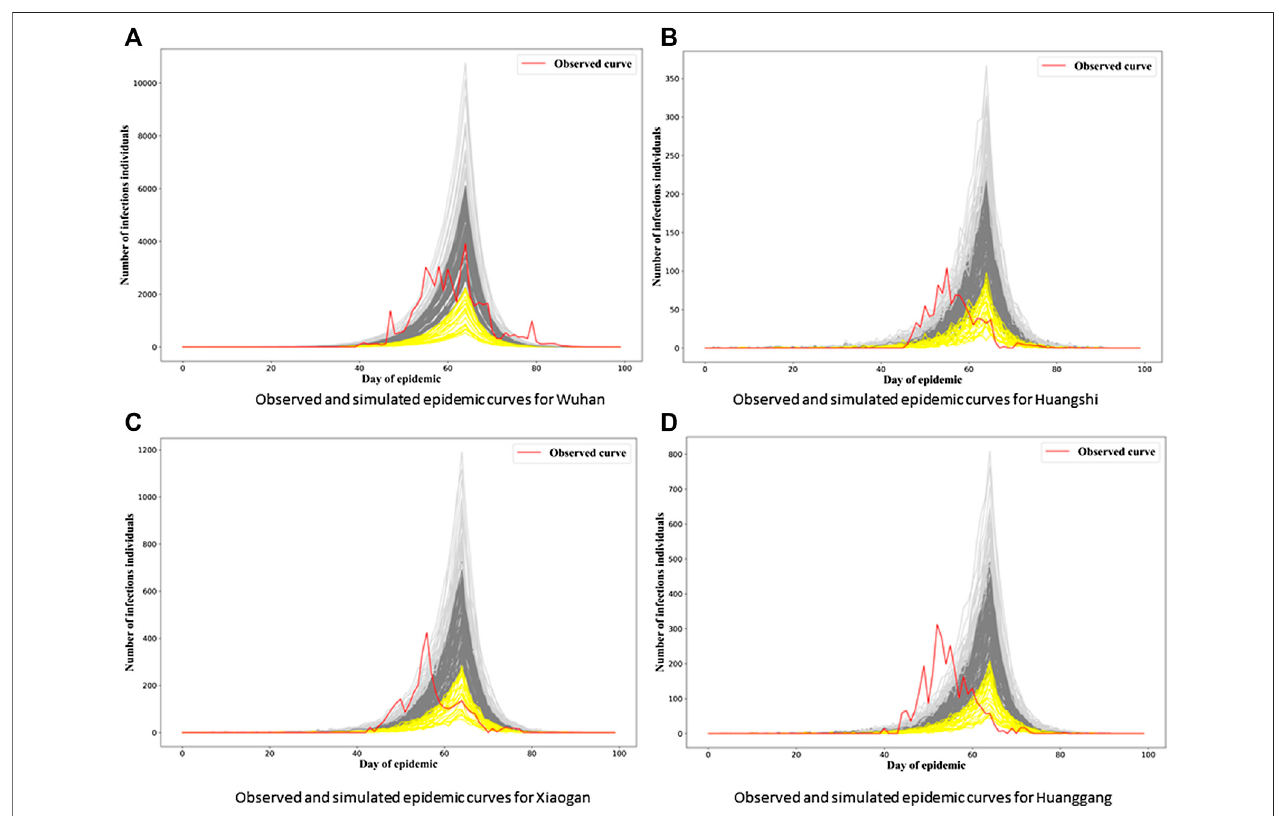
FIGURE2| Observed and simulatedepidemiccurvesunder fi nalmodel forfour citiesin Hubei. Realdata shown inred;lightgray and yellow curves represent15% strongest and weakest epidemics simulated from the fi nal model, respectively; remaining dark gray curves represent remaining 70% of simulated epidemics.